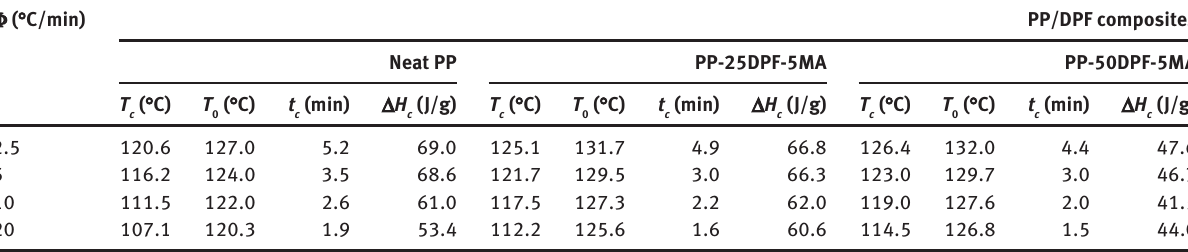
Table 1: Values of the crystallization temperature ( T crystallization ( Δ H ) of neat polypropylene (PP) and its composite materials at different cooling c